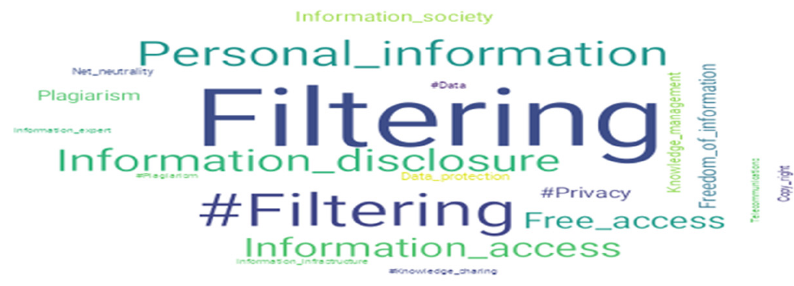
Figure 4. Word cloud of keywords .